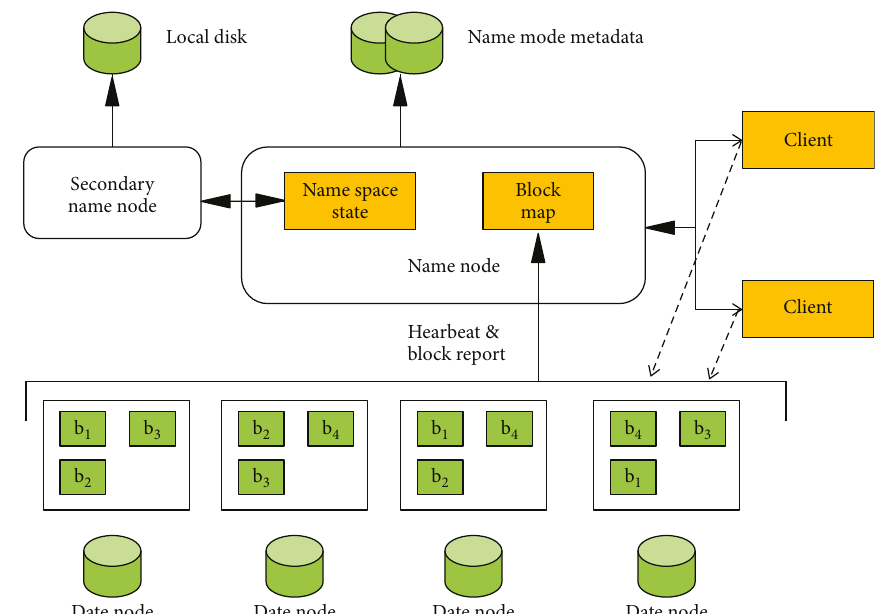
Figure 1: Balanced distributed computer resource